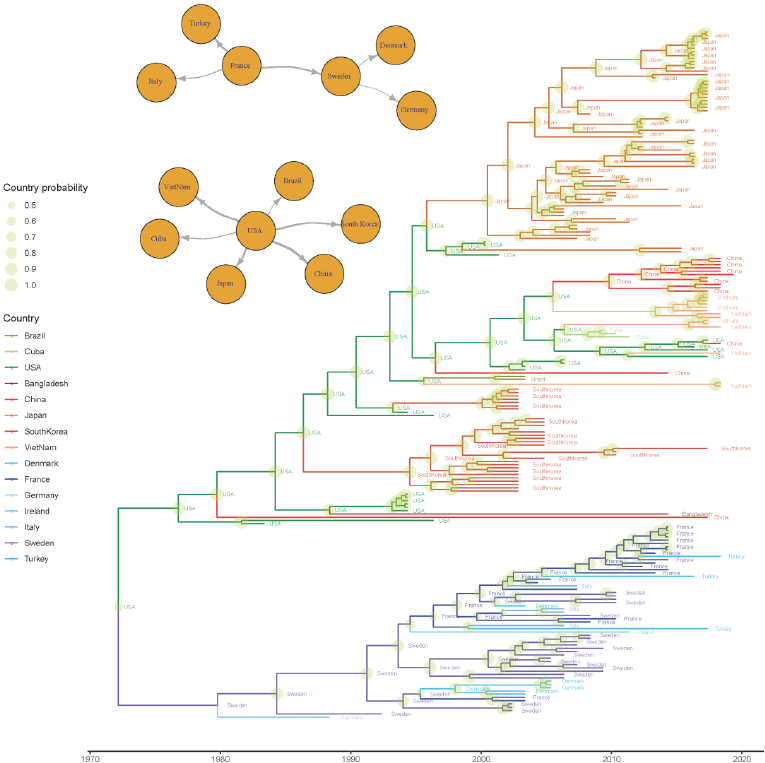
Figure 4. Time-scaled phylogenetic tree based on BoCV spike protein. The estimated ancestral geographic location has been color-coded (different nuances of green, red, and blue have been selected for American, Asian, and European countries), while the posterior probability is depicted as a circle on the corresponding node, whose size is proportional to the estimated value. The statistically supported migration routes have been represented in the upper left insert.